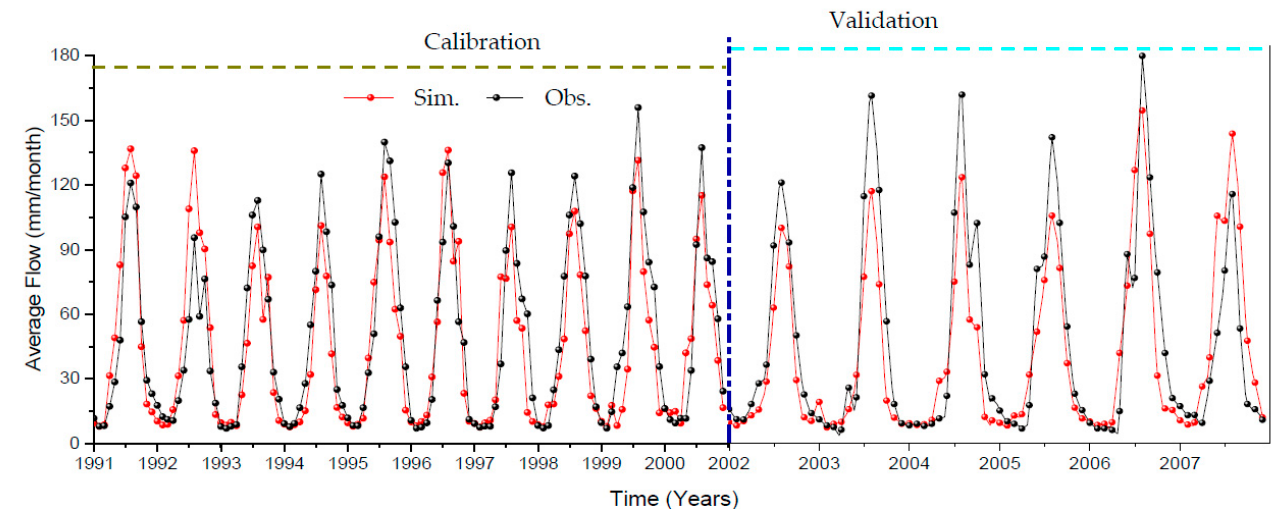
Figure 5. Observed and simulated monthly flow hydrograph for calibration (1991–2000) and validation periods (2002–2007).